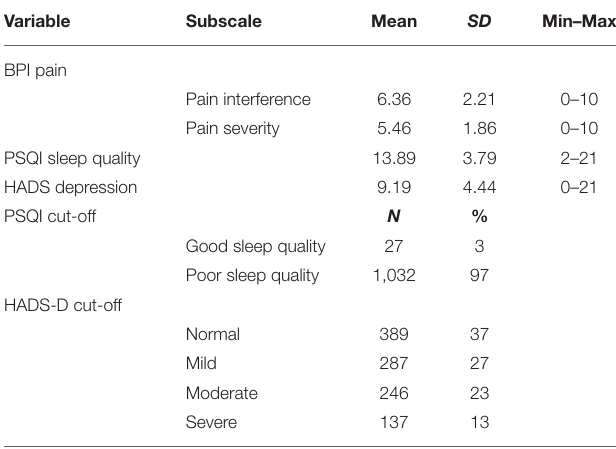
TABLE 4 | Moderated multiple regression for pain severity and pain interference as predictor variables and sleep quality as moderator variable on depression.